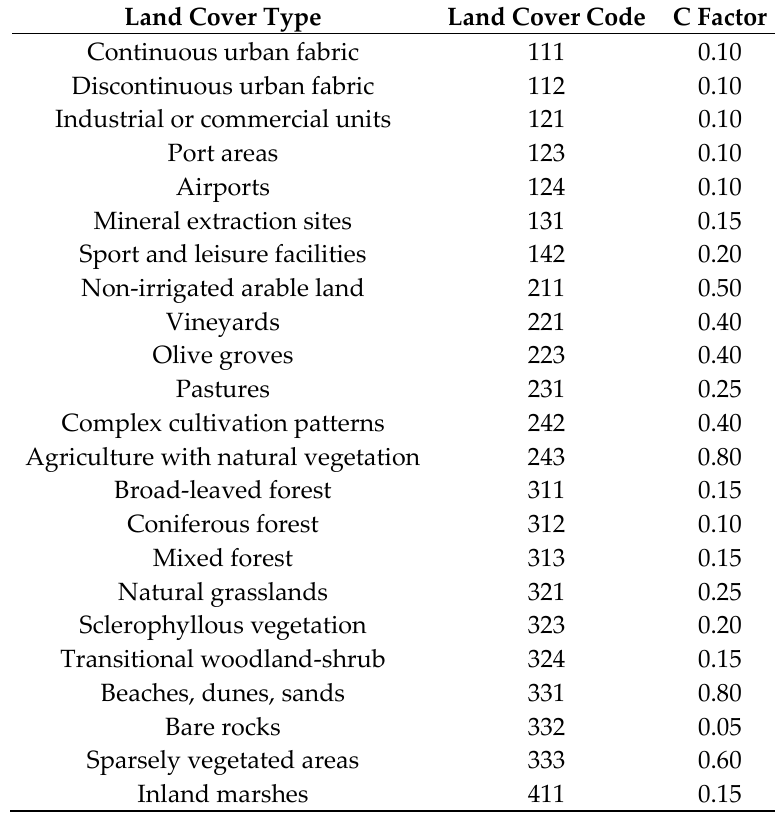
Figure 2. Vegetation management factor (C) maps of Cephalonia Island in the year 2000 ( above ) and 2012 ( below ). Table 2. C values as they were assigned according to land cover map